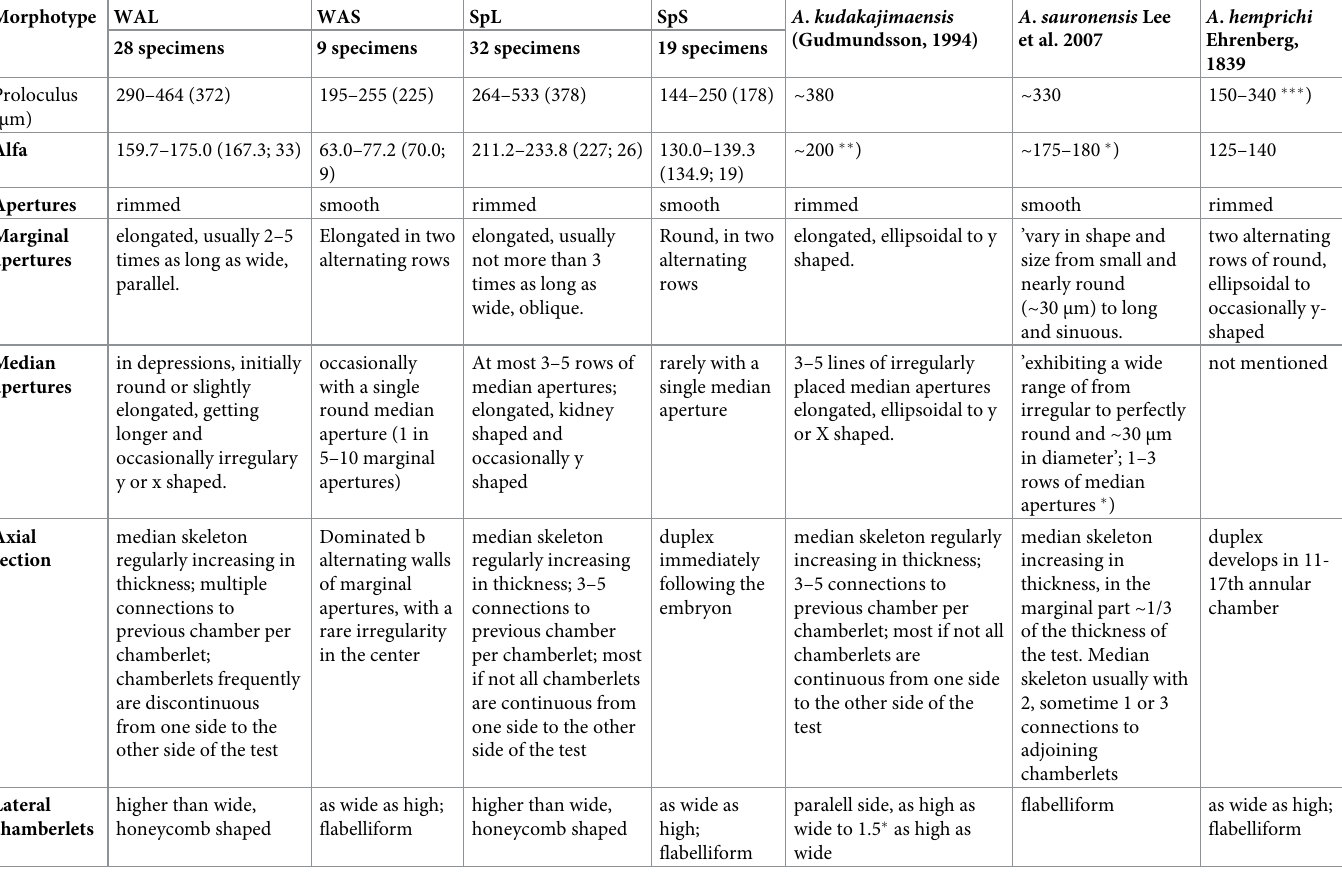
Table 1. Comparison of morphological characters of Amphisorus morphotypes described in this study (West Australia Large (WAL), West Australia Small (WAS), Spermonde Large (SpL), Spermonde Small (SpS)) and previously described Amphisorus species. Morphotype